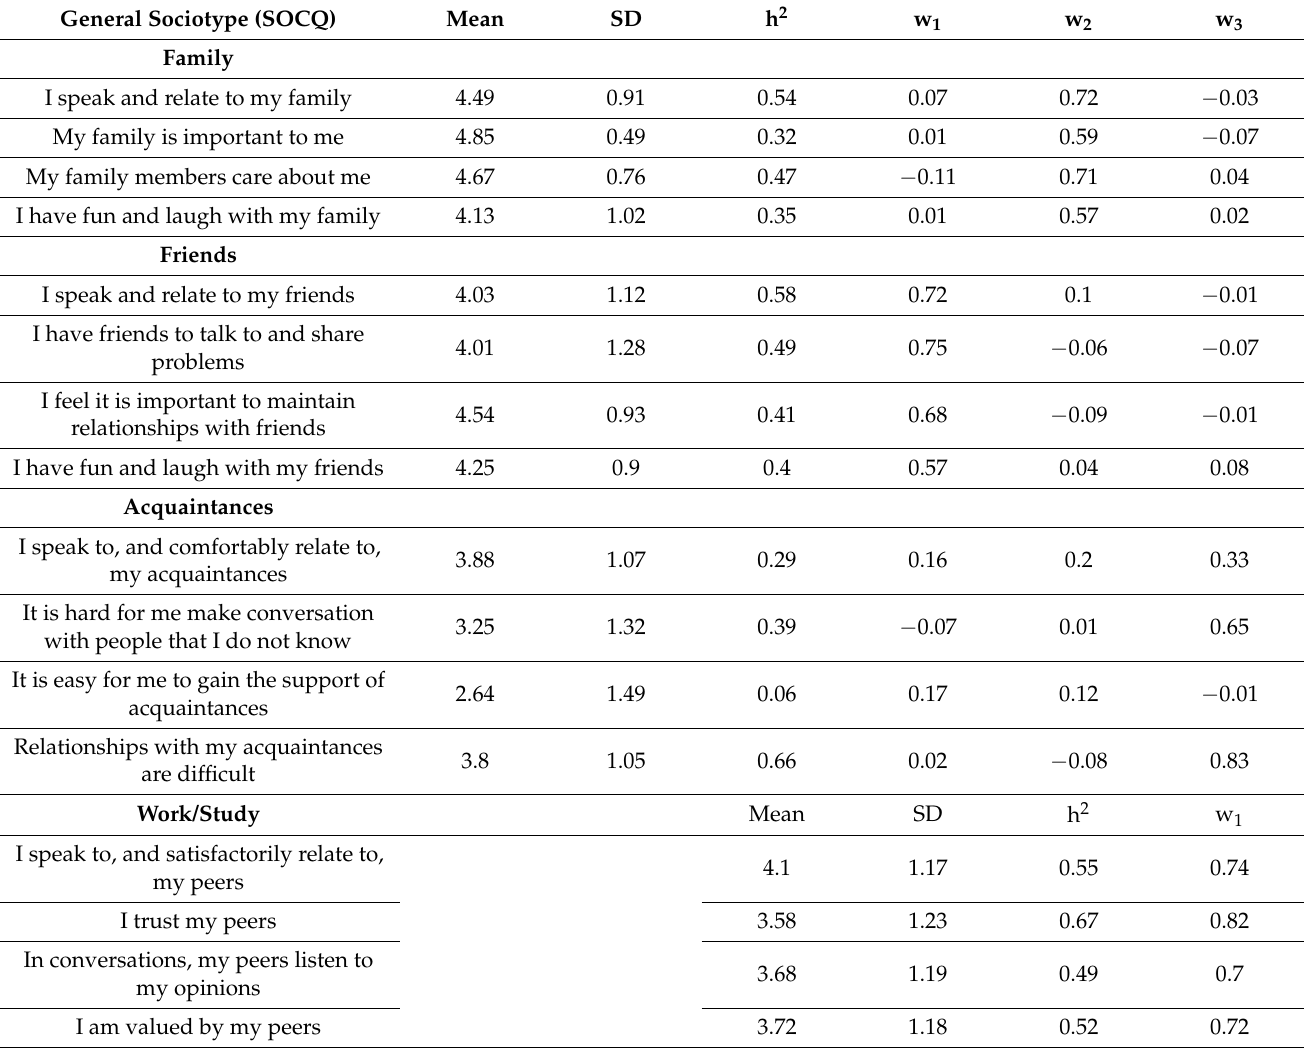
Table 2. Factorial